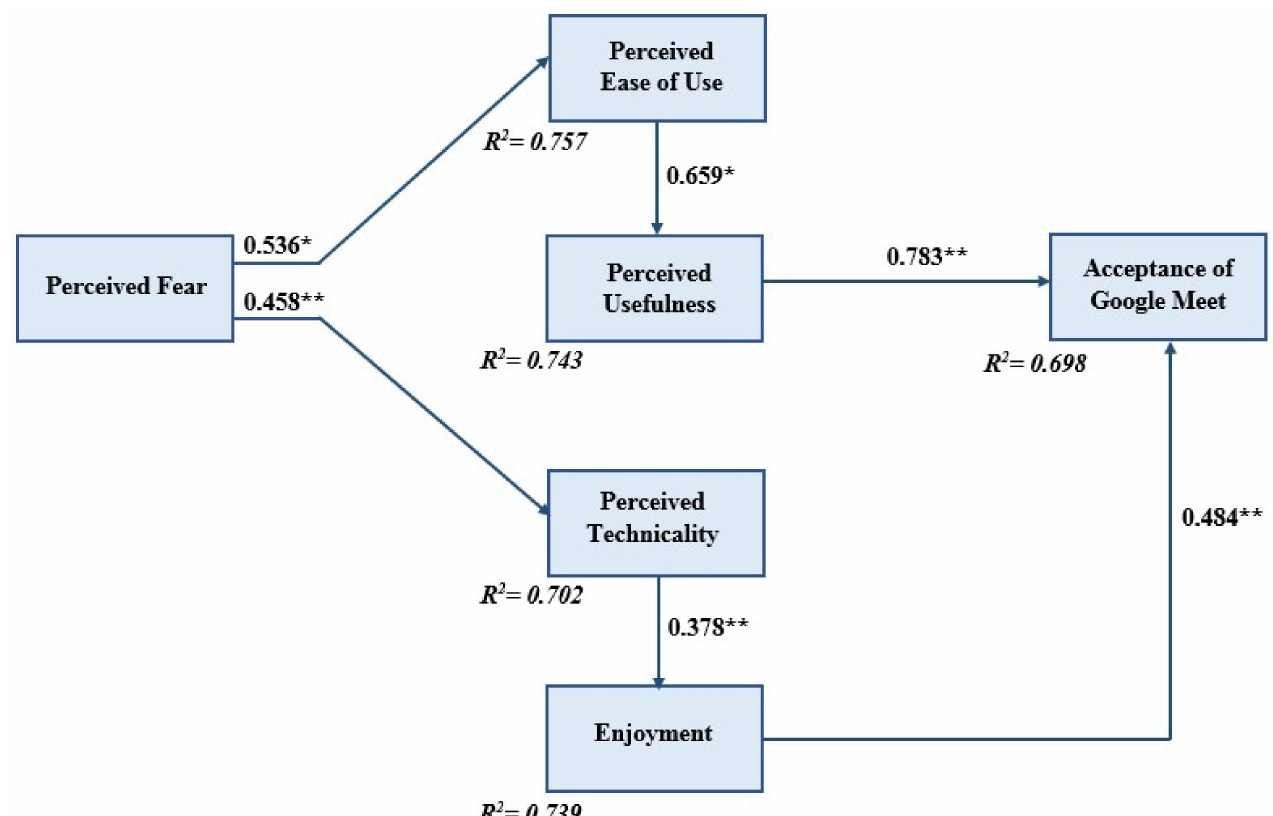
Figure 2. Path coefficient of the model (significant at ** p ≤ 0.01, * p <